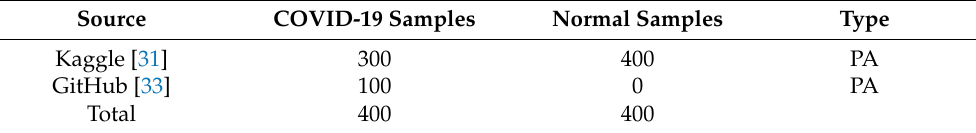
Table 1. Dataset information.